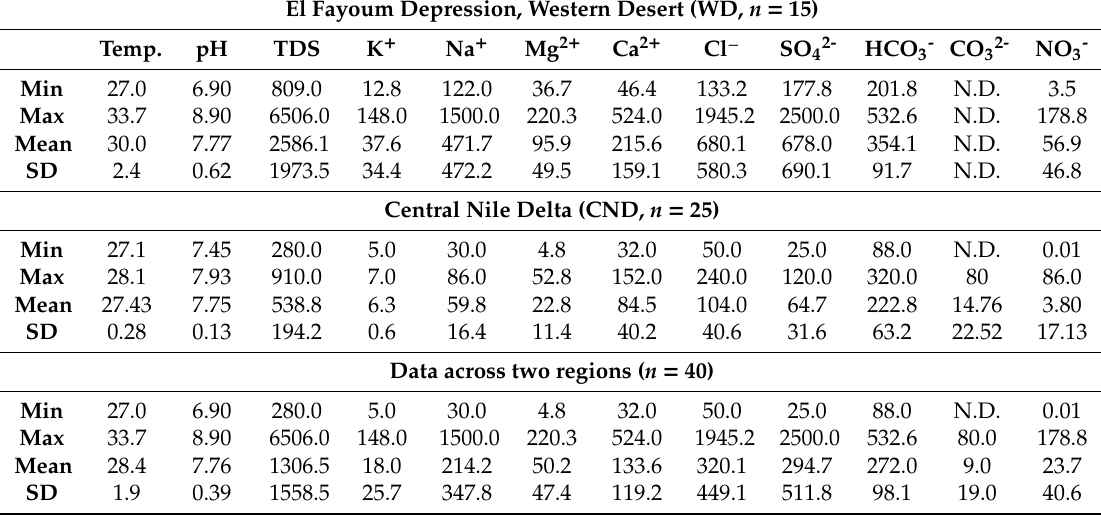
concentration of anions, respectively (Table 3). Table 3. Minimum (Min), maximum (Max), mean, and standard deviation (SD) of the concentrations of di ff erent measured physicochemical parameters of groundwater samples in the Western Desert and Central Nile Delta. All values are expressed in mg L − 1 except for temperature ( ◦ C) and pH. El Fayoum Depression, Western Desert (WD, n = 15) Temp.